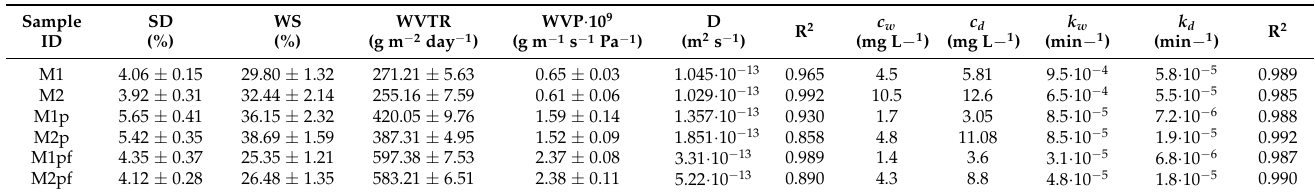
Table 2. Swelling degree, water solubility, water vapor transmission rate, water vapor permeability of composite membranes, TC-HCl diffusion coefficients, and So and Macdonald model parameters ( c w , c d , k w , k d